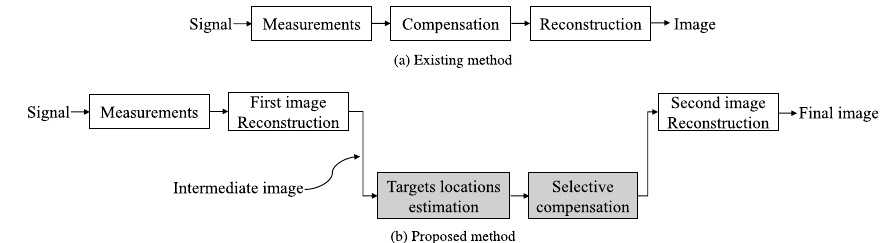
Fig. 2 Path-loss compensation